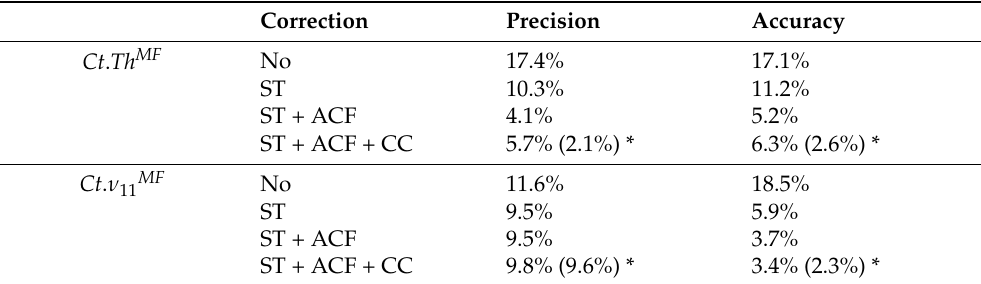
Table 5. Precision and accuracy of Ct . Th MF and Ct . ν 11 MF for each PAC method for all 64-element aperture models. Reference thickness for all models is Ct . Th Ref = 4 mm. Models without cortical pores have Ct . ν 11 Ref = 3504 m/s. Reference values Ct. ν 11 Ref for models including cortical pores can be found in Table A3 in Appendix